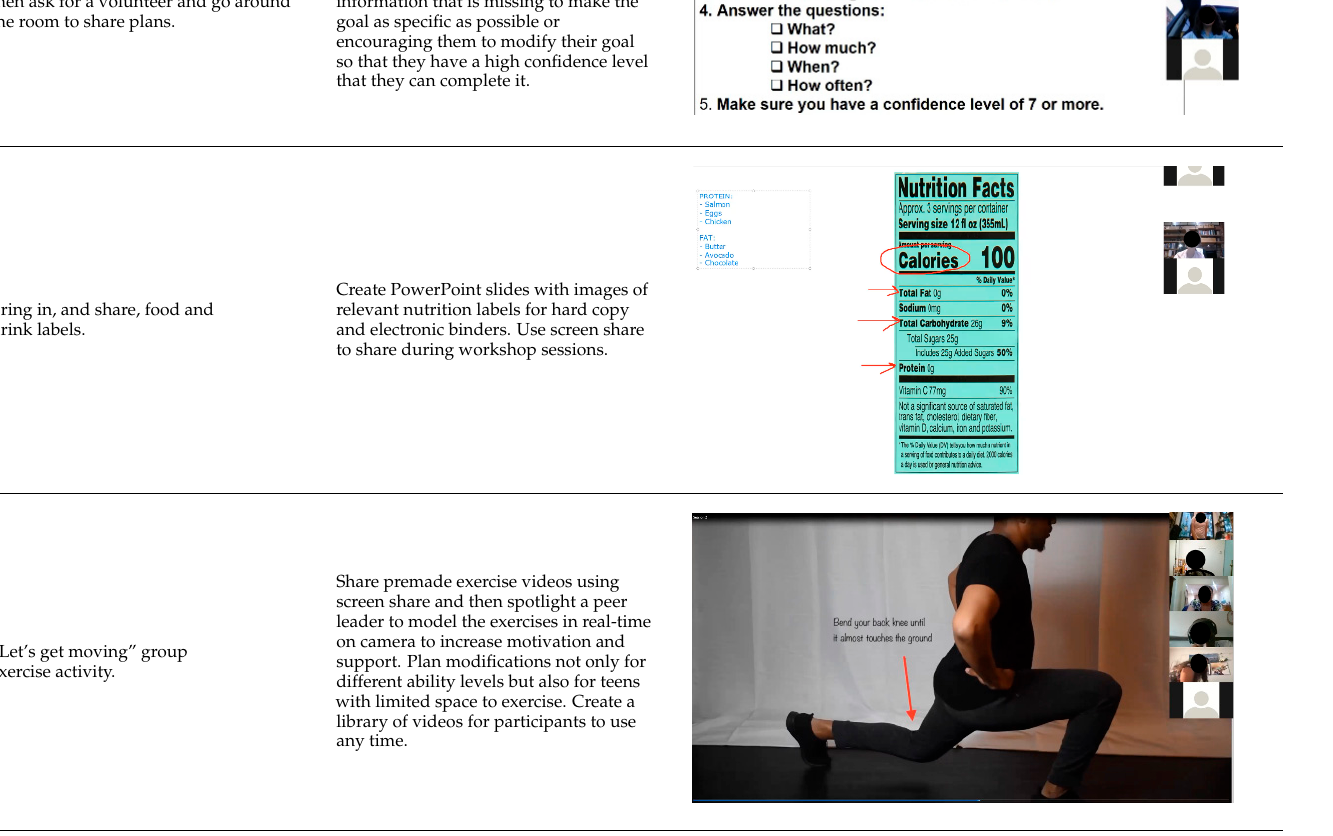
Table 1. Adaptations for virtual program